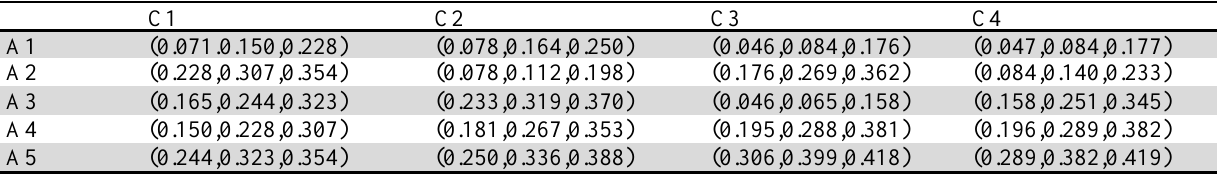
Normalized fuzzy decision matrix for